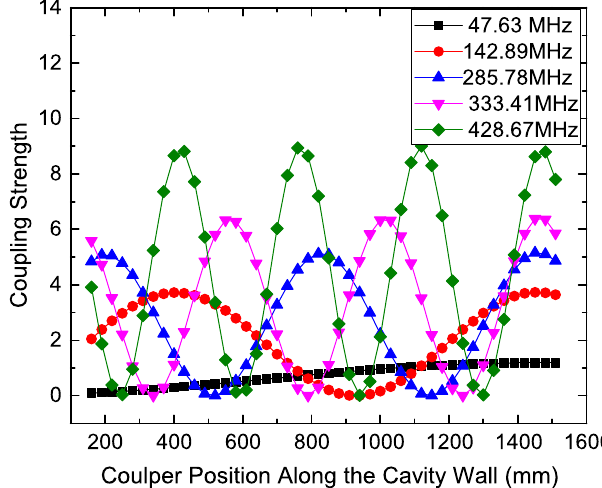
FIG. 12. Coupling strength for each mode at different locations along the cavity wall. Coupler loop size and orientation are fixed in this